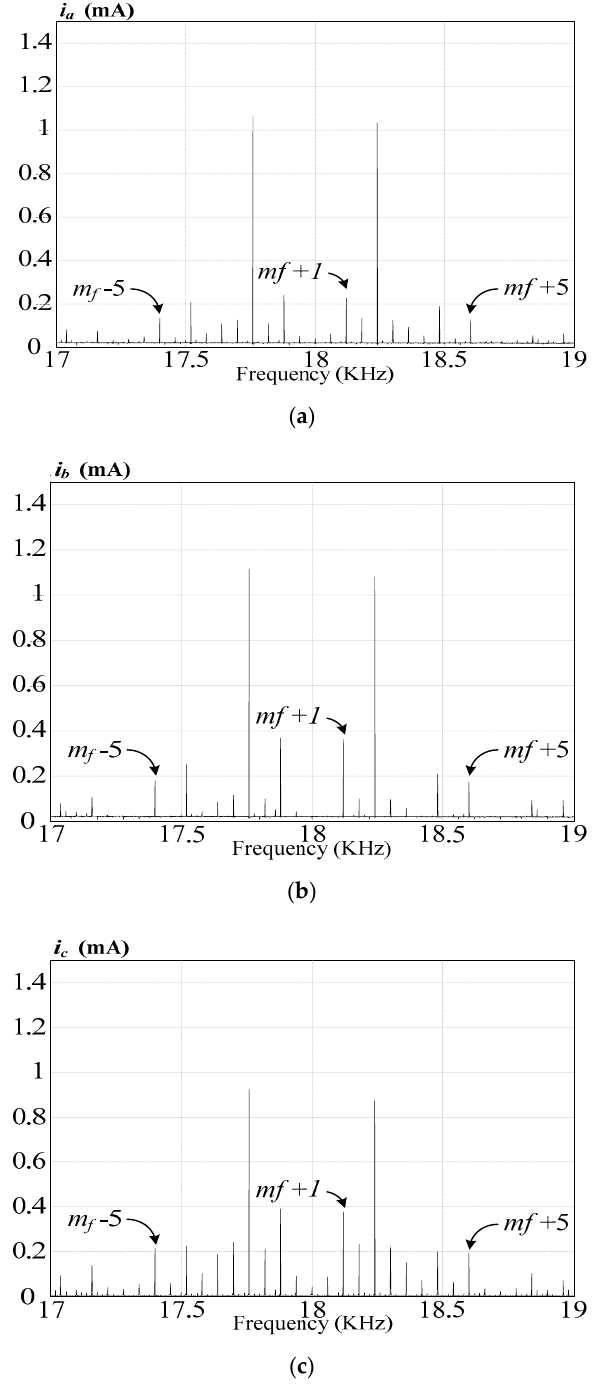
Figure 8. Frequency spectra of line currents for an inverter working at 60 Hz with faulty switch Sc 2 + : ( a ) line current i a ; ( b ) line current i b ; ( c ) line current i c .